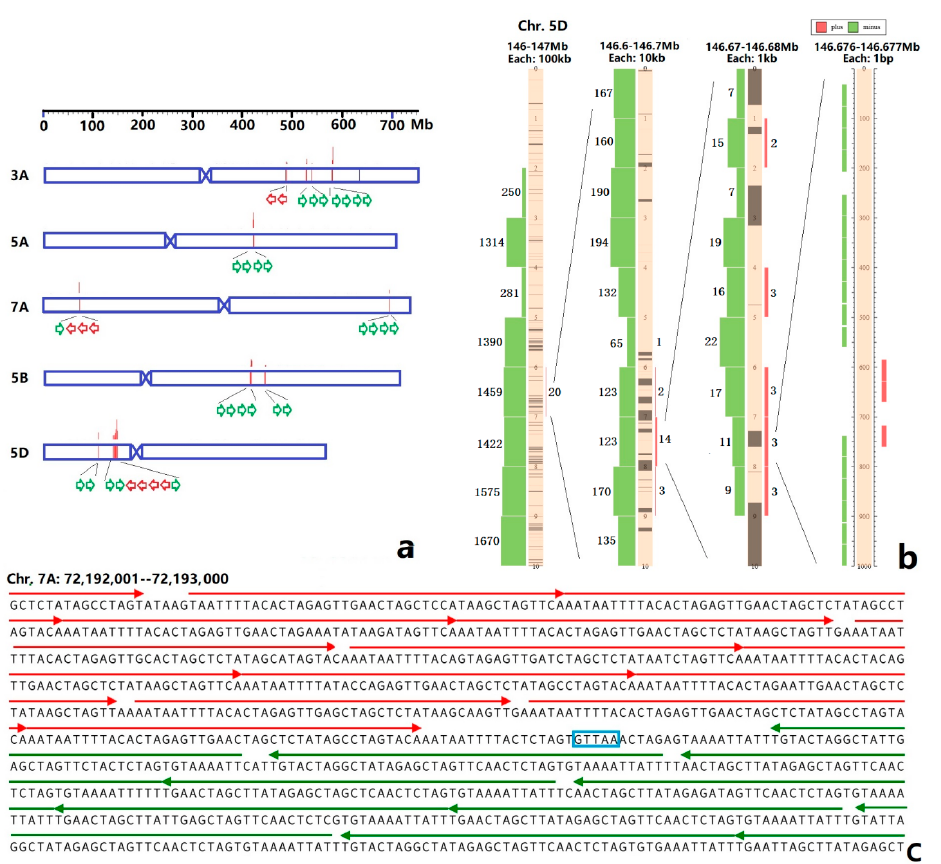
Figure 2. The predicted physical location of Ta-3A1 in wheat genome. The overview of Ta-3A1 on five chromosomes ( a ), copy number in a region of 5D ( b ), and an array of sequences on 7A ( c ) were indicated, respectively. The arrows represent the mini-satellite array, and green and red arrows show the minute and plus strand, respectively.